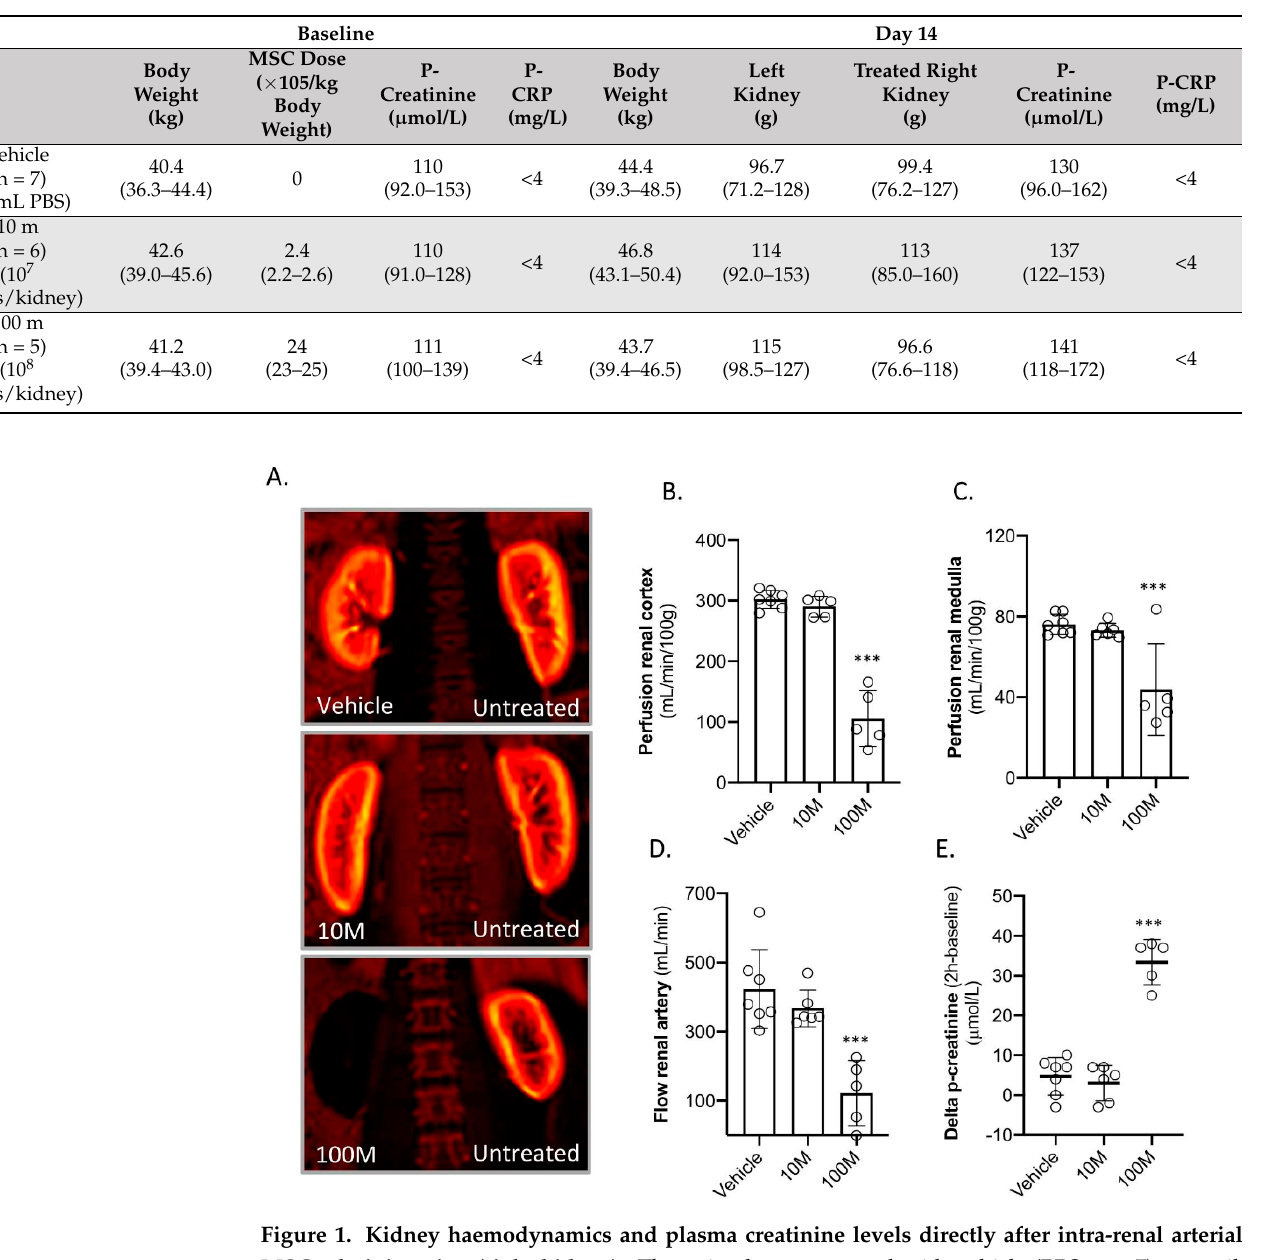
Table 1. Basic characteristics at baseline and after 14 days follow-up. The data presents the mean